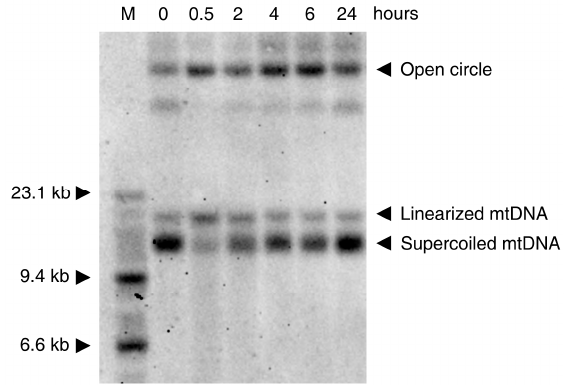
Figure 2 . Southern blot showing the time course of native mtDNA damage caused by 1 mM H 2 O 2 and followed by the DNA repair by HEK293 cells. M: molecular weight marker; 0: control DNA (from untreated cells); The cells were exposed to 1 mM H 2 O 2 and harvested after 30 min, 2 h, 4 h, 6 h, 24 h, respectively. 1 µ g of total DNA was loaded on a 0.6% agarose gel prepared in tris-borate-EDTA (TBE) buffer and was run in the presence of 0.5 µ g/mL ethidium bromide overnight at 40 V. After alkaline treatment and re-neutralization of the gel, the DNA was blotted to a Zeta-Probe membrane (Bio-Rad, Hercules, CA, USA) and immobilized by baking at 80 ◦ C for 30 min. The blot was hybridized with a MT-ND6